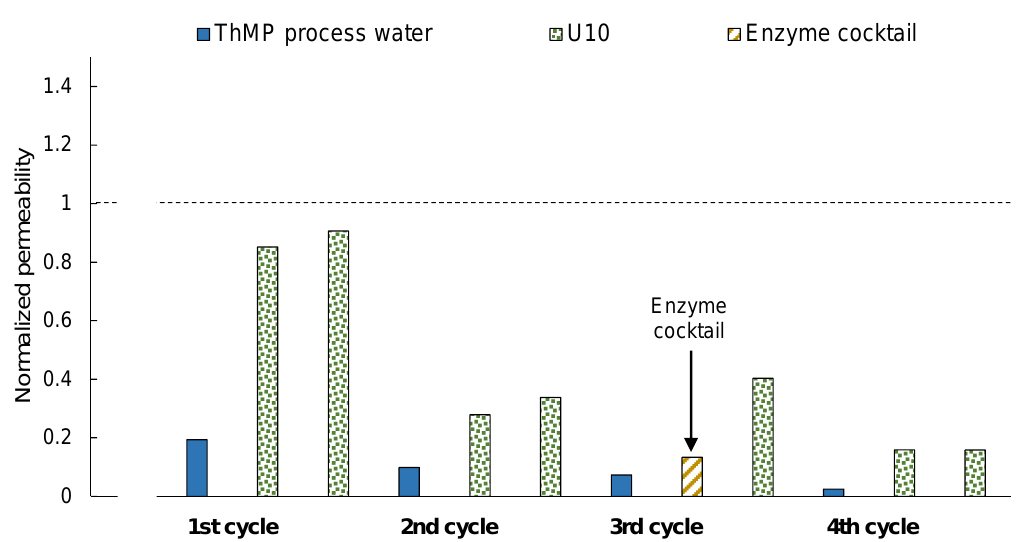
Figure 4. Normalized membrane permeability after fouling with ThMP process water (black) and subsequent two-step cleaning. The unshaded bars show the normalized permeability after cleaning with Ultrasil 10, and the shaded bar after cleaning with the enzyme cocktail. The same membrane sample was used for the complete experiment.